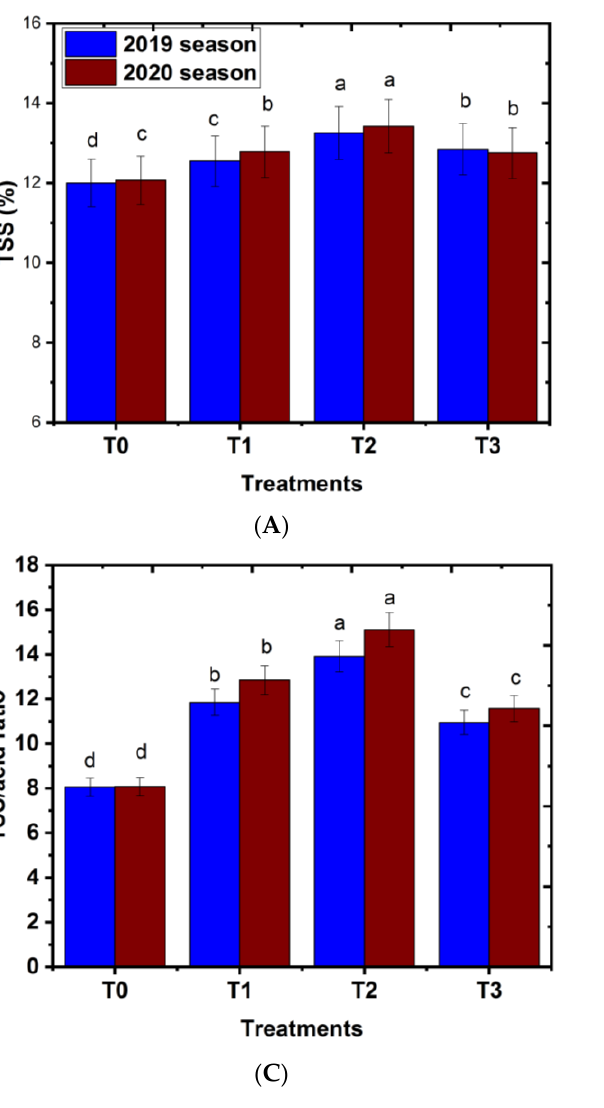
Figure 6. Effect of magnetic iron application on fruit chemical properties of ‘Chinese’ mandarin trees during 2019 and 2020 seasons. ( A ) TSS%, ( B ) total acidity, ( C ) TSS/acid ratio, and ( D ) vitamin C. T0: 0 g magnetic iron.tree −1 , T1: 250 g magnetic iron.tree −1 , T2: 500 g magnetic iron.tree −1 , and T3: 750 magnetic iron.tree −1 . Bars indicate mean values ± SE ( n = 9). Different letters above columns indicate significant differences among magnetic iron treatments at p = 0.05 according to Bartlett’s test.